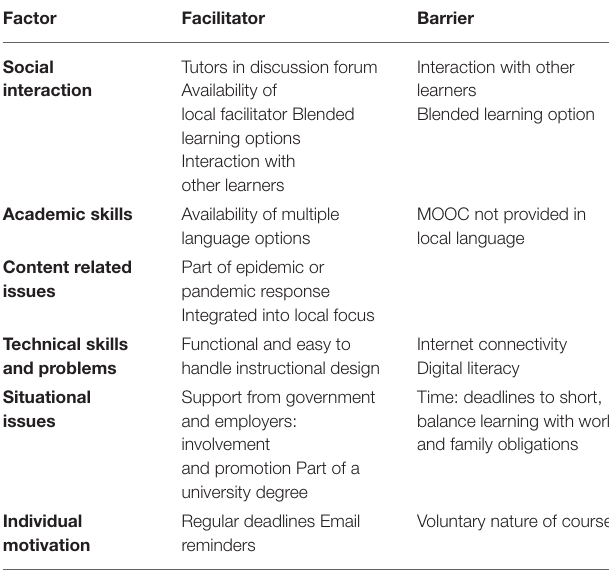
TABLE 5 | Facilitators and barriers of learning by MOOC.